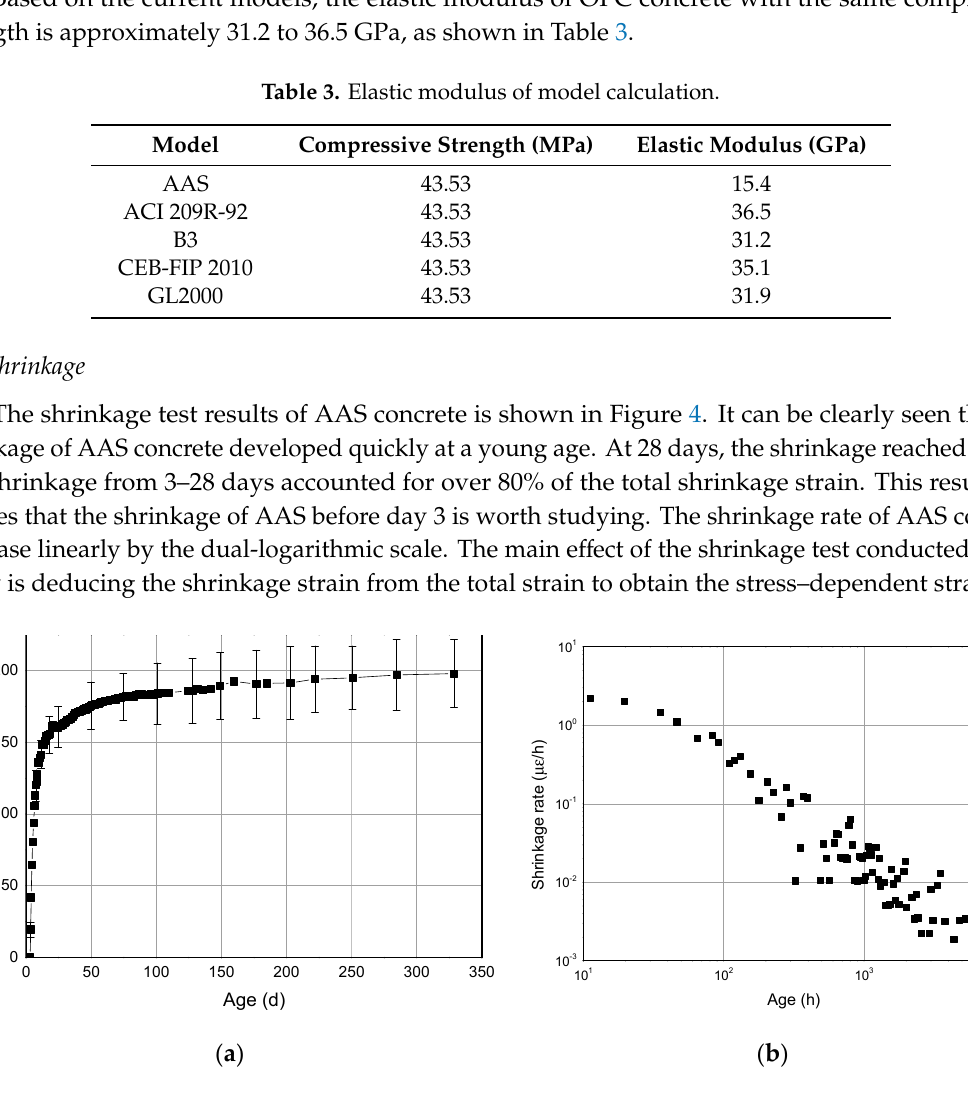
Figure 4. Shrinkage strain of AAS concrete from day 3. ( a ) shrinkage strain; ( b ) shrinkage rate 。